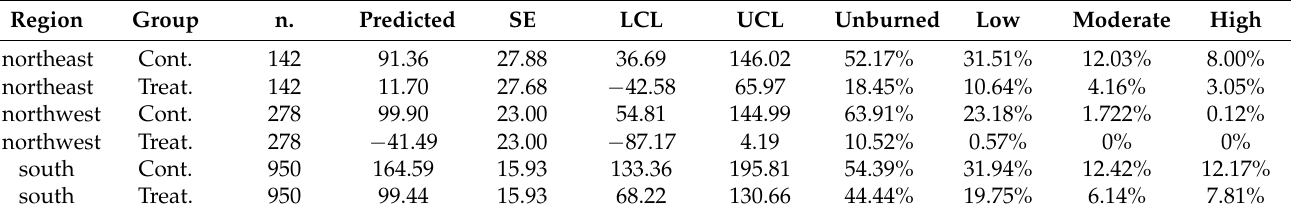
Figure 4. Predicted fire severity values for golf courses, golf course edges, and non-golf course vegetation by region. Table 2. Predicted values and where the predicted dNBR offset values fall on corresponding MTBS distributions.